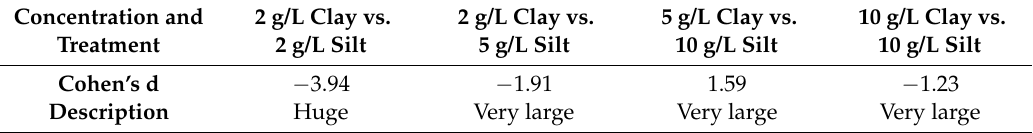
Table 5. Comparison of infiltration rate of clay-sized suspended solids with that of silt-sized suspended solids at 2, 5 and 10 g/L concentration levels using Cohen’s d effect size